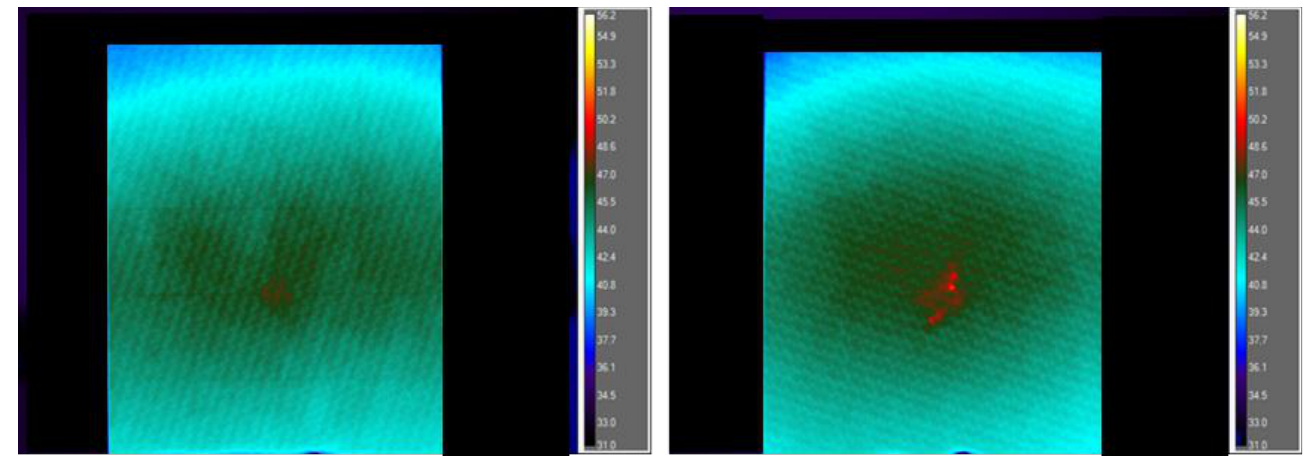
Figure 15. IR thermography of damaged RTM6 laminates at 9 J ( left ) and 15 J ( right ).